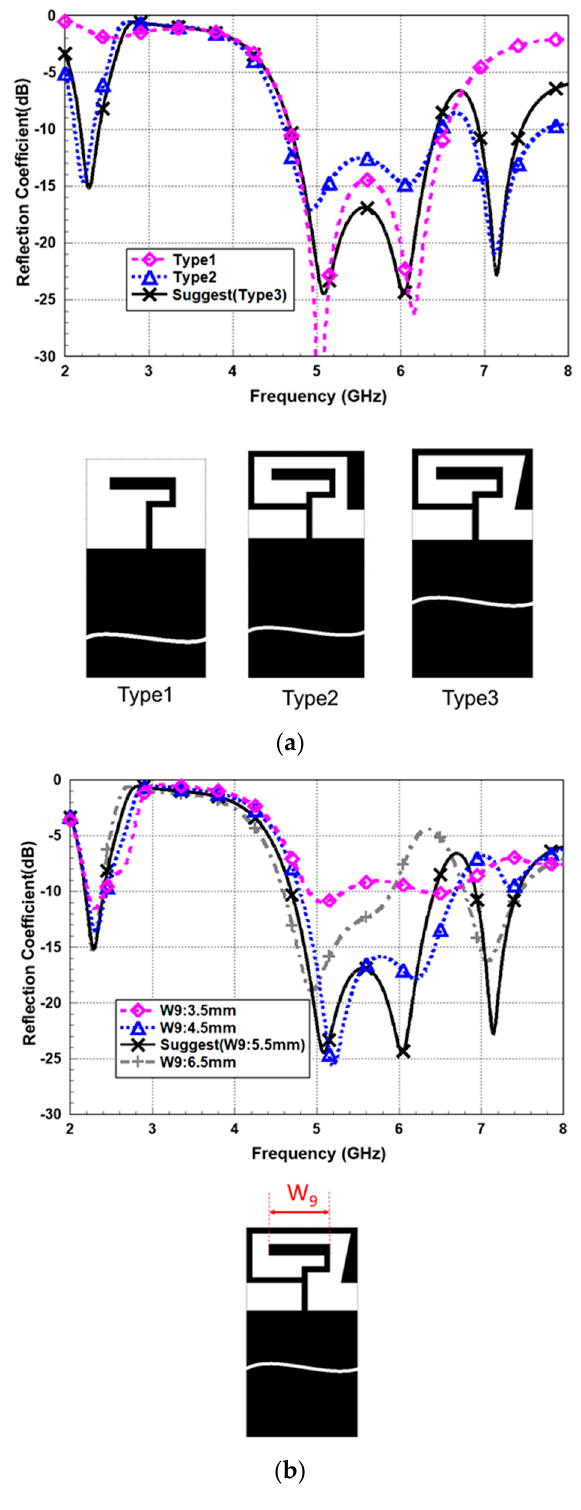
Figure 4. The evolution analysis with various types and lengths for the proposed antenna: ( a ) evolution analysis of antenna design with type 1, 2, and 3; ( b ) strip length W 9 .